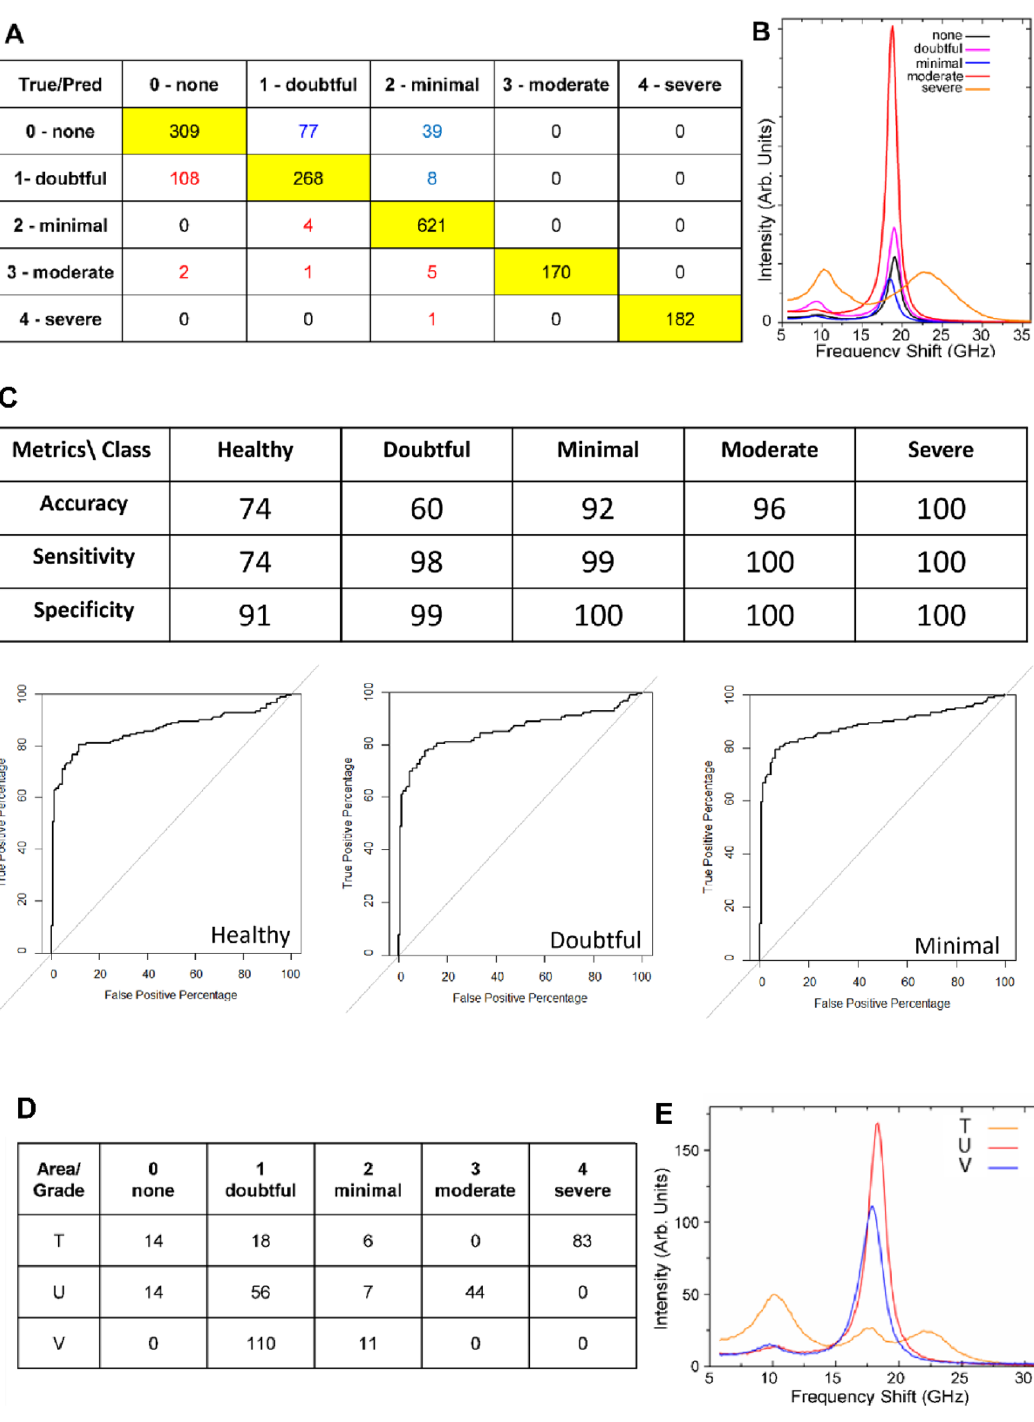
Figure 6. LDA modelling for machine learning application applied on the Brillouin spectra collected on the articular cartilage surface of MWB sections and LDA-based ML classification of fast Brillouin spectra collected in different areas of the articular cartilage (MWB-sample#5). ( A ) Confusion matrix obtained by the application of the LDA-based ML algorithm to the test-set correspondent to the remanent 25% of spectra selected. The right assignments are given in the yellow boxes along the diagonal, where false-negative and false-positive are red and blue coloured, respectively. ( B ) Averaged spectra of each category, namely, none (black), doubtful (magenta), minimal (blue), moderate (red) and severe (orange) used in the model. ( C ) Table reporting the main model metrics calculated on the five classes (top) along with the ROC curves for the healthy, doubtful and minimal phenotypes, respectively. ( D ) Results of the classification of fast spectra collected in different areas of the MWB section of sample#5, namely T (orange), U (red) and V (blue), along with the ( E ) averaged spectra of each